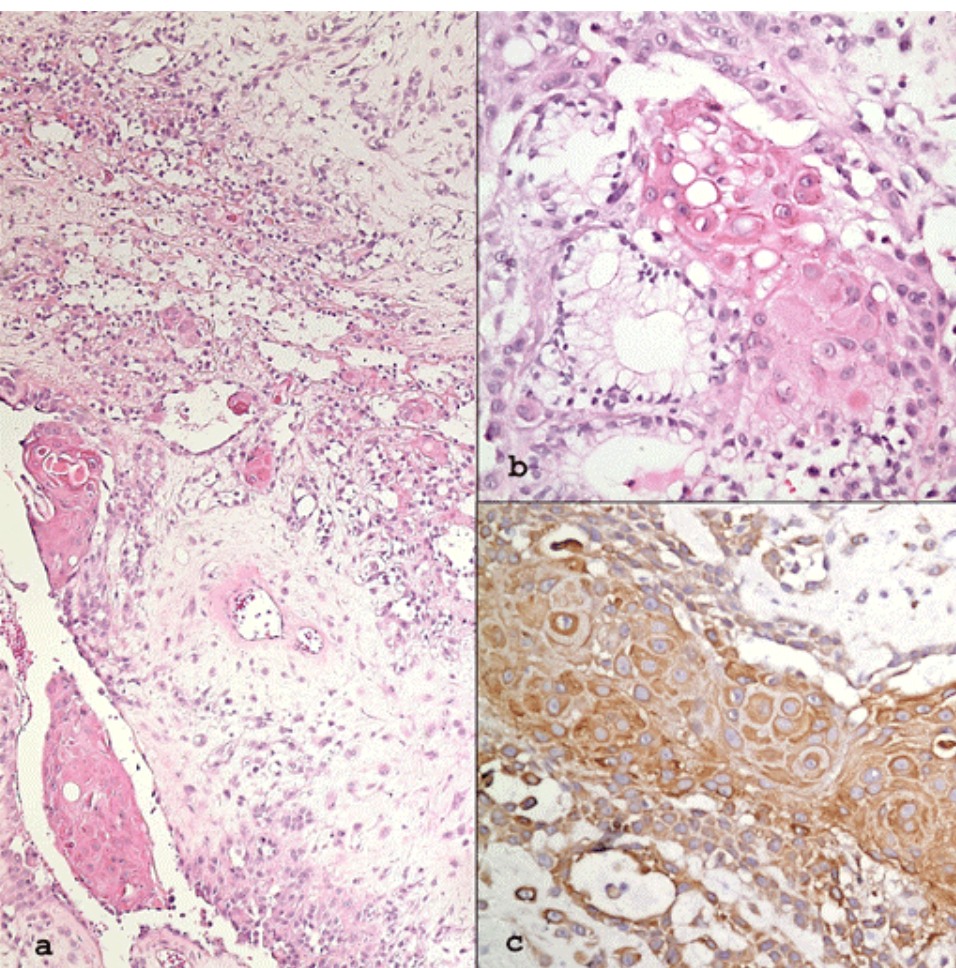
FIGURE 1. (a) Adenosquamous carcinoma with sarcomatous transformation (H-E × 100); (b) adenoid and squamous elements side by side (H-E × 200); (c) both glandular and squamous components express PSA immunohistochemically (immunohistochemistry, anti-PSA Ab ×